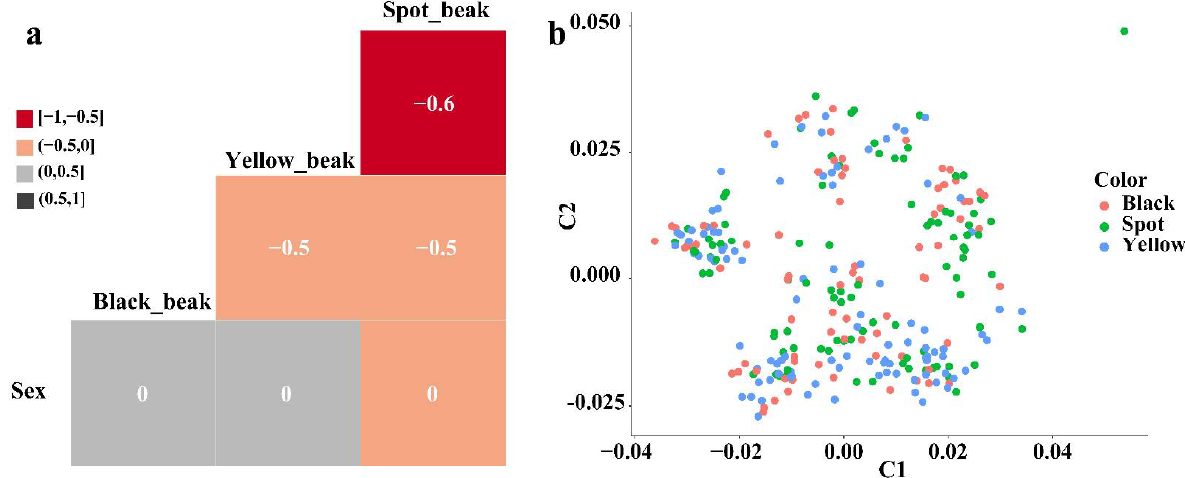
Figure 1. Beak color and sex correlation analysis ( a ); population structure analysis ( b ).